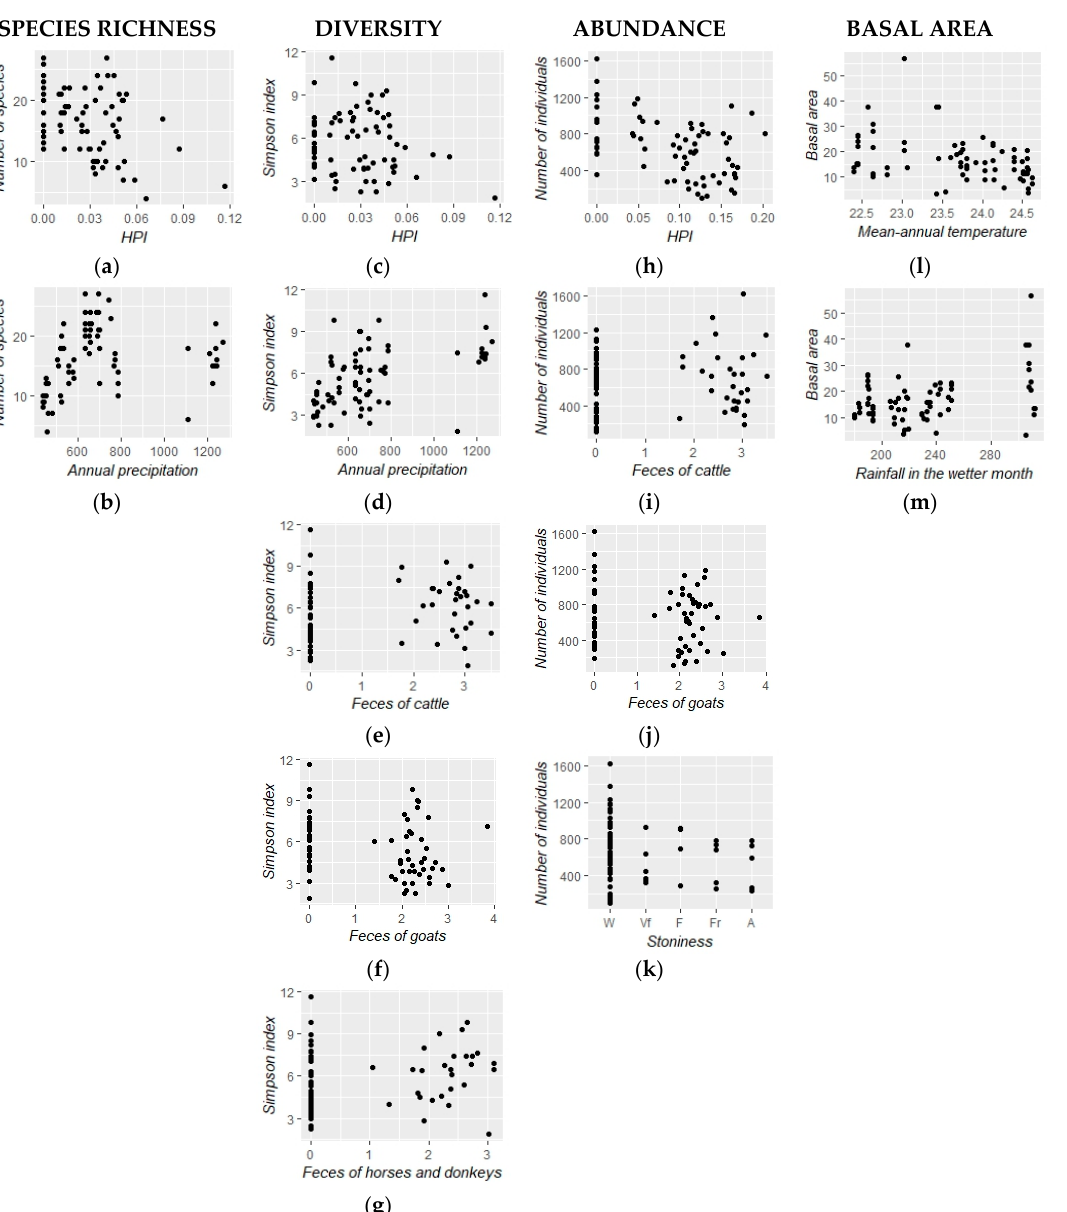
Figure 5. Relationships among the predictors that partially contribute to the best models of each assessed variable. In ( a , c , h ) HPI is log-transformed. In ( k ), the horizontal axis represents the stoniness categories: W = Without; Vf = Very few; F = Few; Fr = Frequent; A = Abundant. In ( e – g , i – j ) the feces are expressed in grams log-transformed.